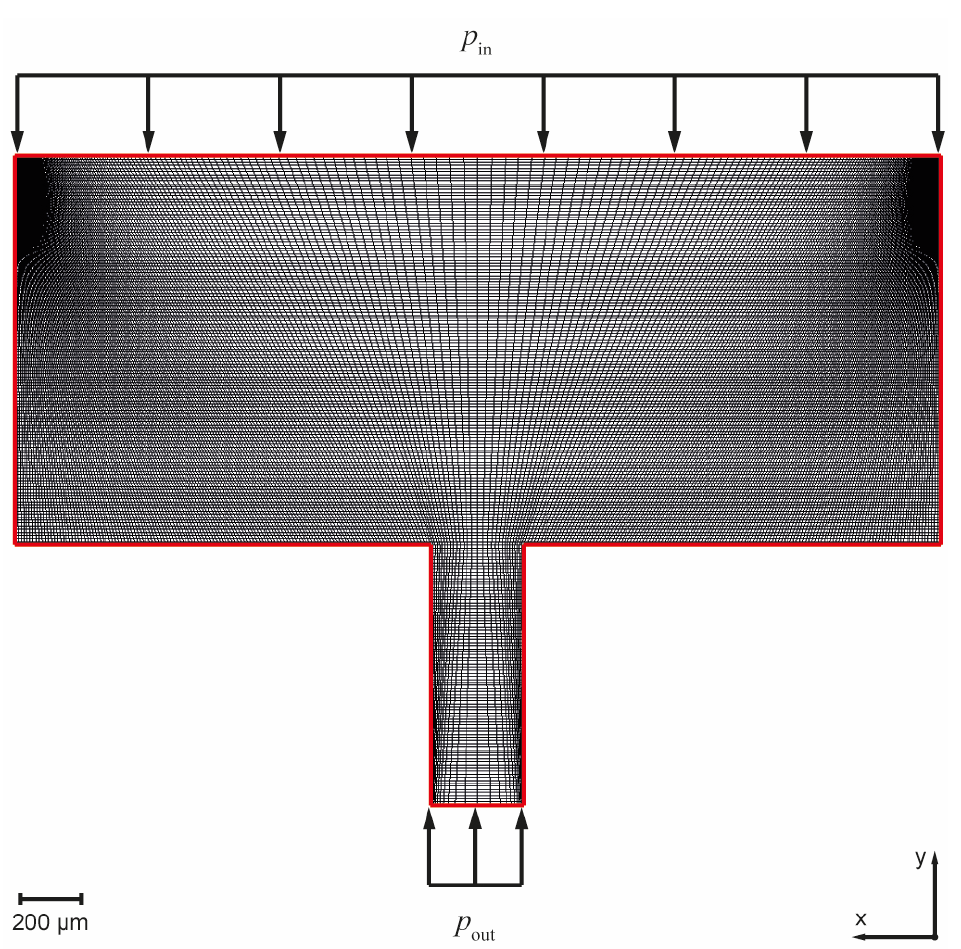
Figure 4. Mesh and boundary conditions used for the fluid simulation.